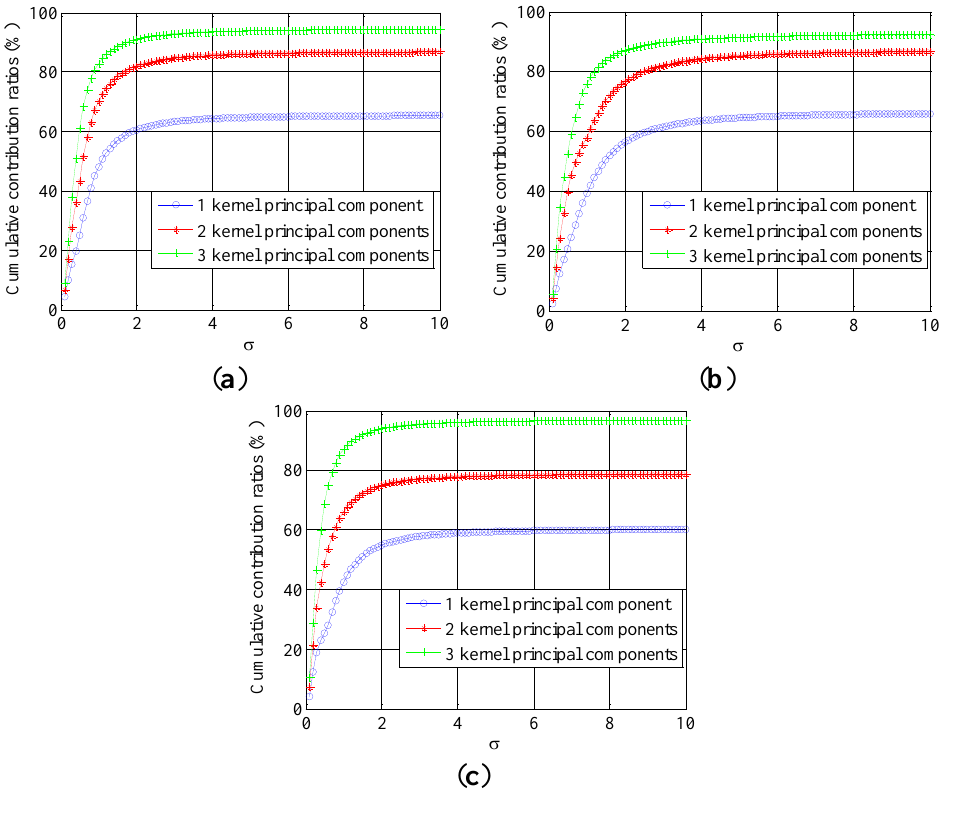
Figure 14. Cumulative contribution ratios of kernel principal components. ( a ) RH = 80%; ( b ) RH = 85%; ( c ) RH = 90%.